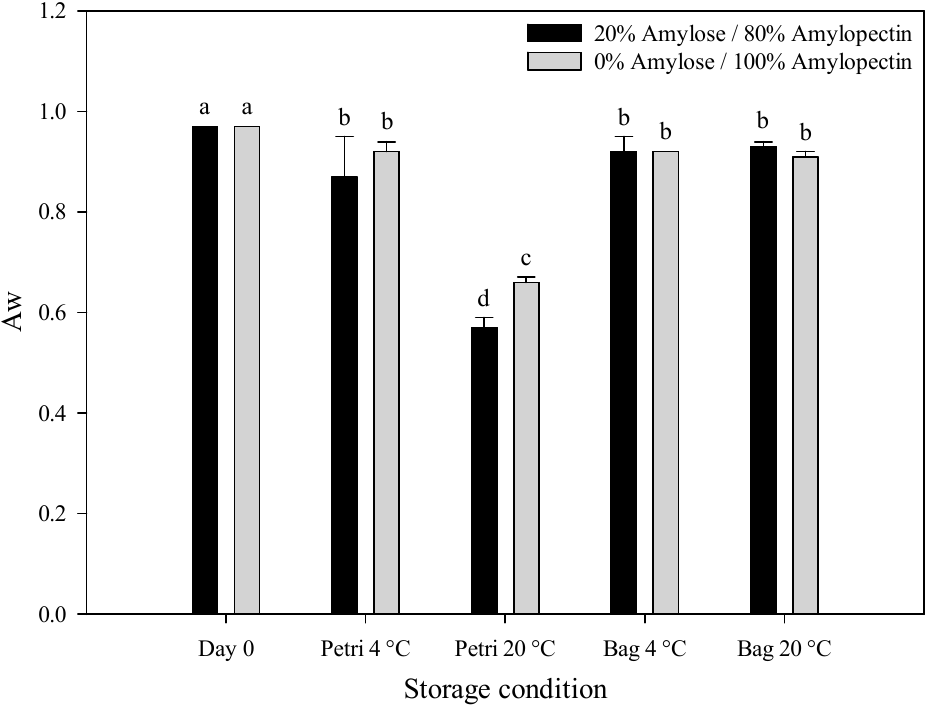
Figure 4. Water activity of hydrogels with different amylose/amylopectin content packed in Petri dishes and plastic bags at day 0 (immediately after HPP treatment) and after 30 days of storage at 4 °C and 20 °C. a–d Bars marked with different letters indicate significant differences (LSD, p ≤ 0.05).